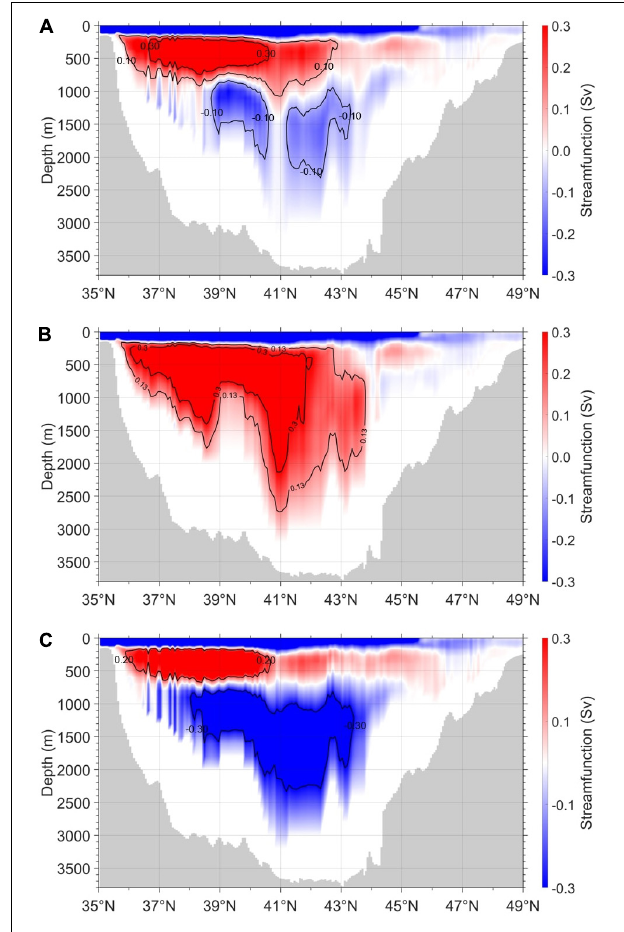
FIGURE 2 | (A) Mean convection (1993–2012), (B) deep convection, (1993, 2002, 2004–2009) and (C) shallow convection (1996–2001 and 2010–2012) cases in the meridional overturning stream functions. The contour intervals are (A) − 0.1, 0.1, and 0.3 Sv; (B) 0.13 and 0.3 Sv; and (C) − 0.3 and 0.2 Sv,